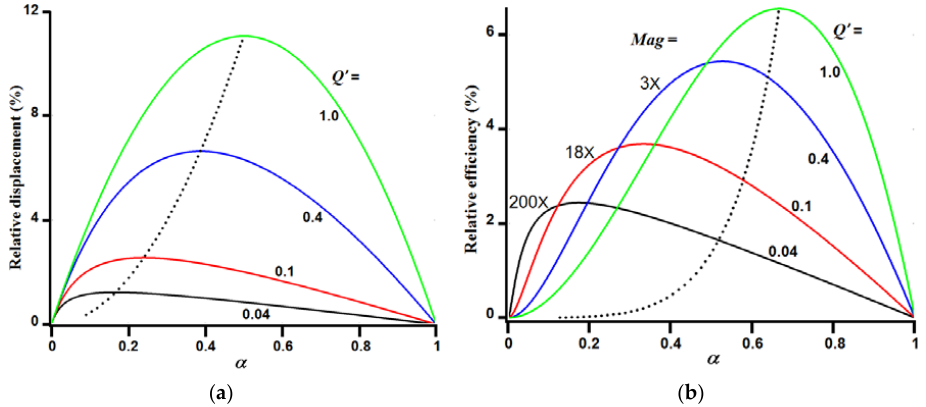
Figure 3. Relative displacements ( a ) and relative efficiencies ( b ) for values of heat deposition from 0.154 to 3.85 J. ( a , b ) are plotted using Equations (3) and (4), respectively, with Equation (6) substituted in for Δ F/F o . The dotted curves show the maximum relative displacements and efficiencies for all values of Q’ from 0.04 to 1.